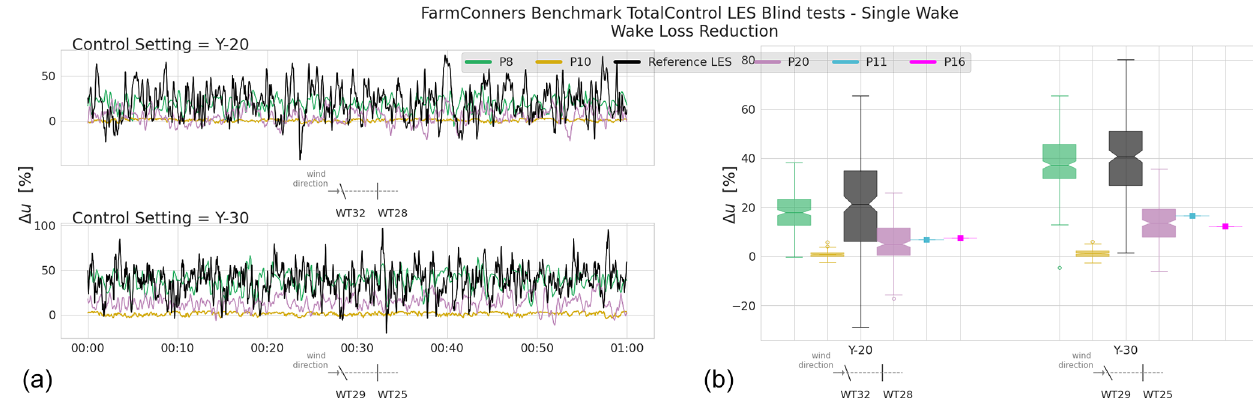
Figure 22. TotalControl LES blind tests, wake loss reduction, (cid:49)u , for single wake under wake steering for two-turbine configurations with 5D spacing (WT32–WT28 with 20 ◦ yaw and WT29–WT25 with 30 ◦ yaw at the upstream turbines). (a) Time series of (cid:49)u , illustrated at the submitted frequency by the participants, for both control scenarios. (b) The distribution of the (cid:49)u within the 1h blind test period for both 20 and 30 ◦ anticlockwise yaw misalignment WFFC scenarios.